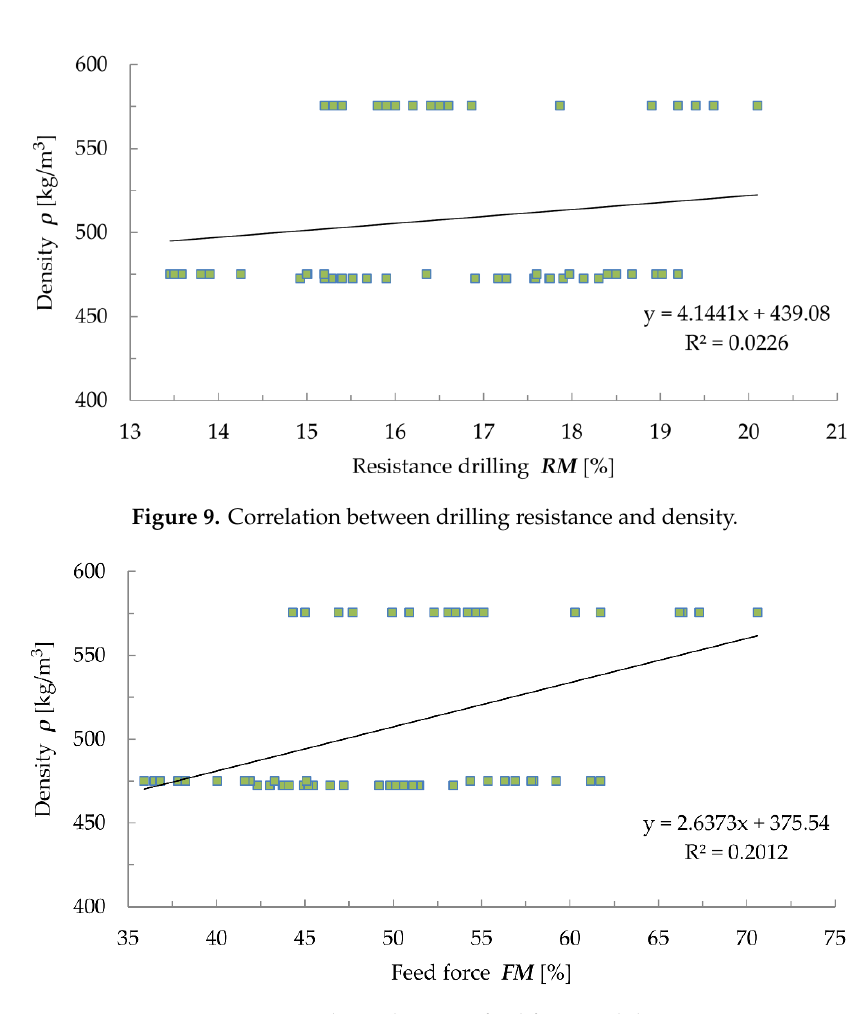
Figure 8. Correlation between drilling resistance and feed force.